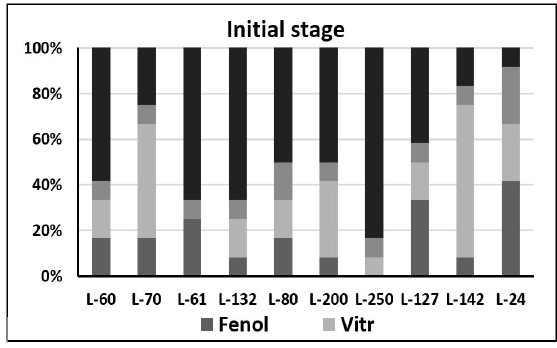
Figure 1. Occurrence of phenolized, vitrified and contaminated microplants of elite clonal lines of thorny artichoke ( Cynara scolymus L.) in the initial